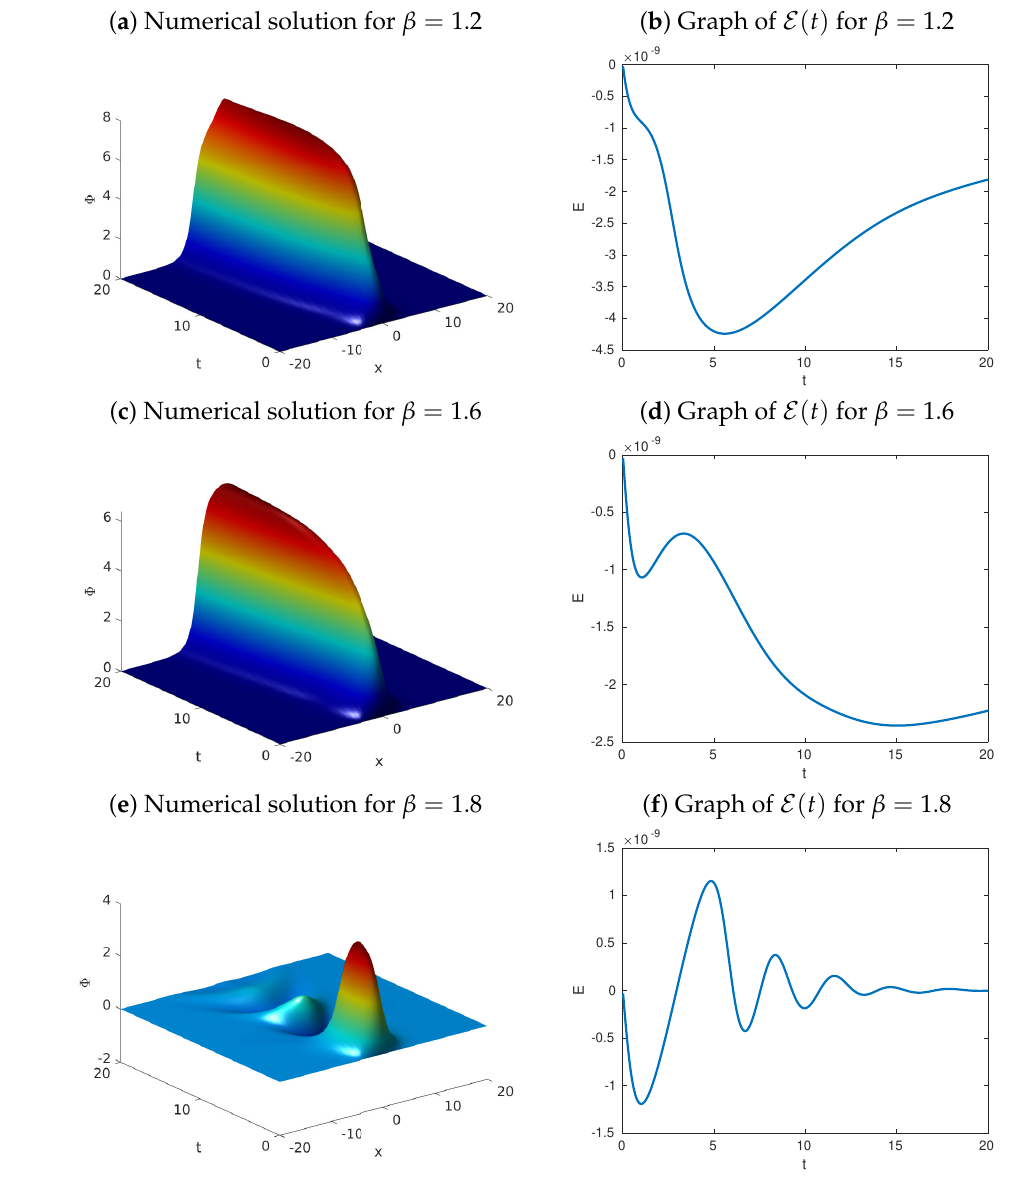
Figure 6. Left column: graphs of the numerical solution for the mathematical model (13). Right column: graphs of the approximate dynamics for the associated functional E . The parameters employed were α = 1.8, γ = 0 and F ( u ) = 1 − cos ( u ) , for each u ∈ R . Moreover, we used β = 1.2 (top row), β = 1.6 (middle row) and β = 1.8 (bottom row). We employed the finite-difference method (42) with Ω = ( − 20,20 ) and T = 20. Computationally, we let h = 0.5 and τ =